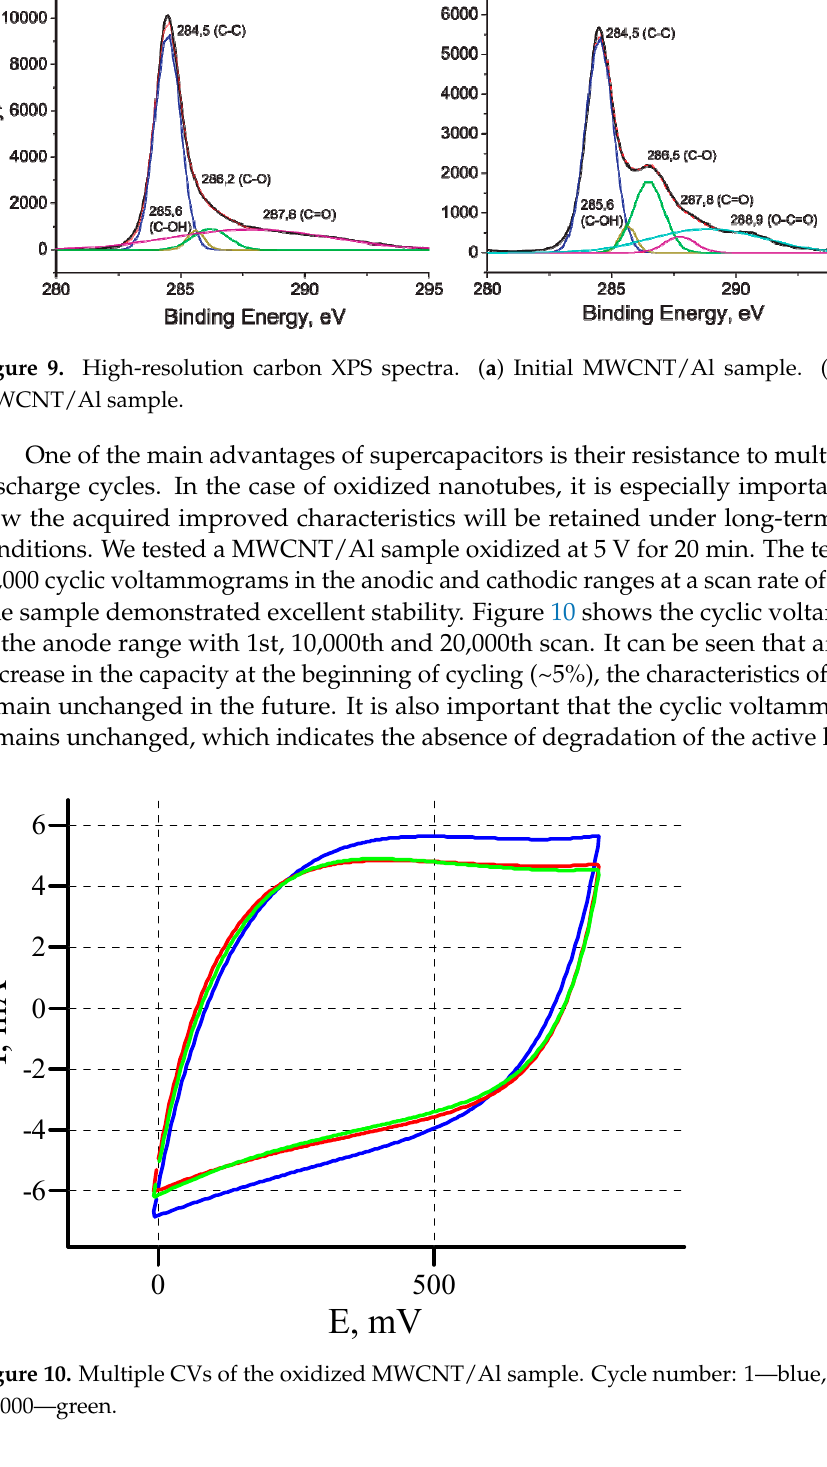
Figure 8. Survey X-ray photoelectron spectra. ( a ) Initial MWCNTs/Al sample. ( b ) Oxidized MWCNTs/Al sample.